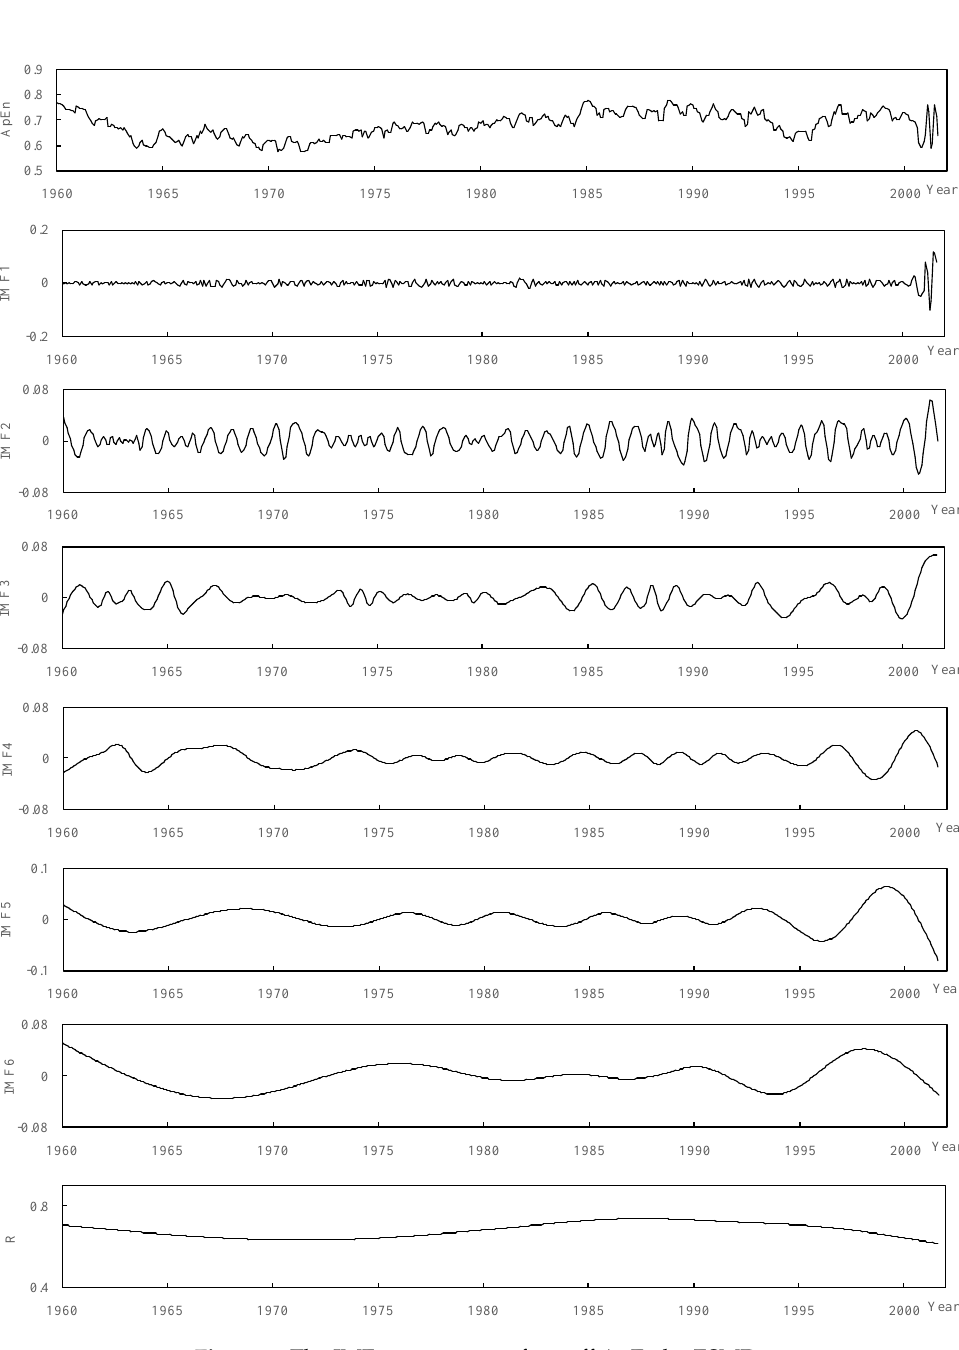
Figure 8. The IMF components of runoff ApEn by ESMD.